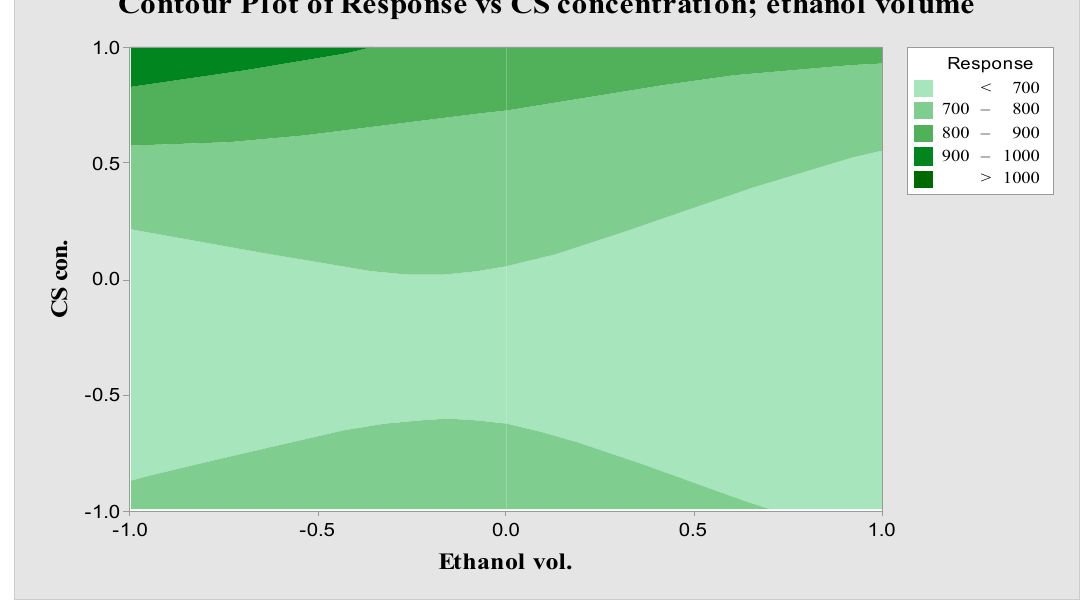
Figure 2. Contour plot for interaction between the concentration of CS and volume of ethanol on the diameter of nanofibers. Table 1. Matrix of CCD; factors and experimental responses.